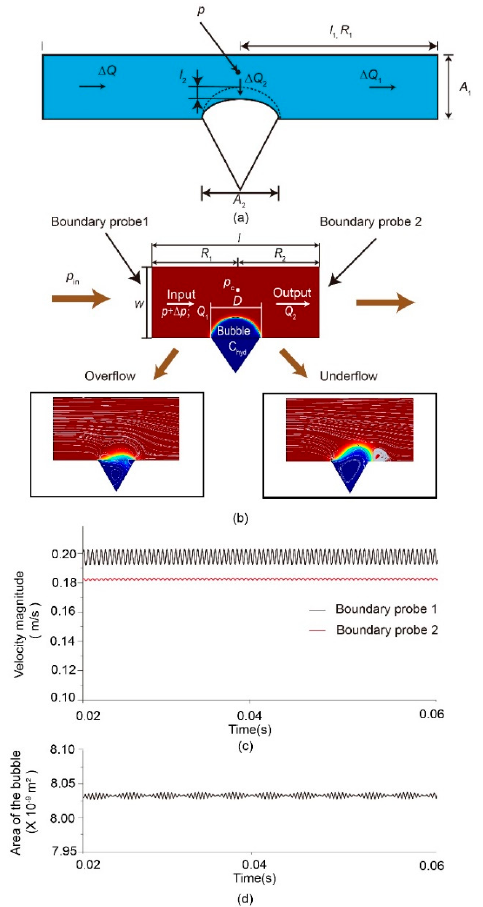
Figure 3. The mechanism of the μ SAB flow stabilization effect: ( a ) the model to understand the effect of bubbles on the reduction of fluctuations; ( b ) the model for the simulation in COMSOL Multiphysics, and the storage and release process of the bubble-based damper. Here, part of the fluid will press the bubble for an overflow, and the fluid stored in the space of the bubble will be released back into the liquid channel for an underflow; ( c ) the flowrate velocity magnitude results of the simulation; ( d ) the bubble variation results of the